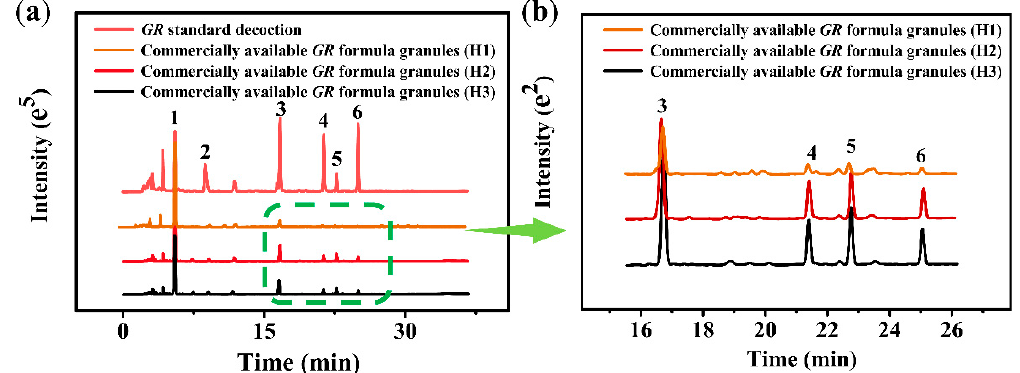
Figure 6. ( a ) Comparison of HPLC fingerprints between 3 batches of commercially available GR formula granules (H1, H2, and H3) and GR standard decoction. ( b ) Enlarged view of the mark areas with green lines in ( a ).